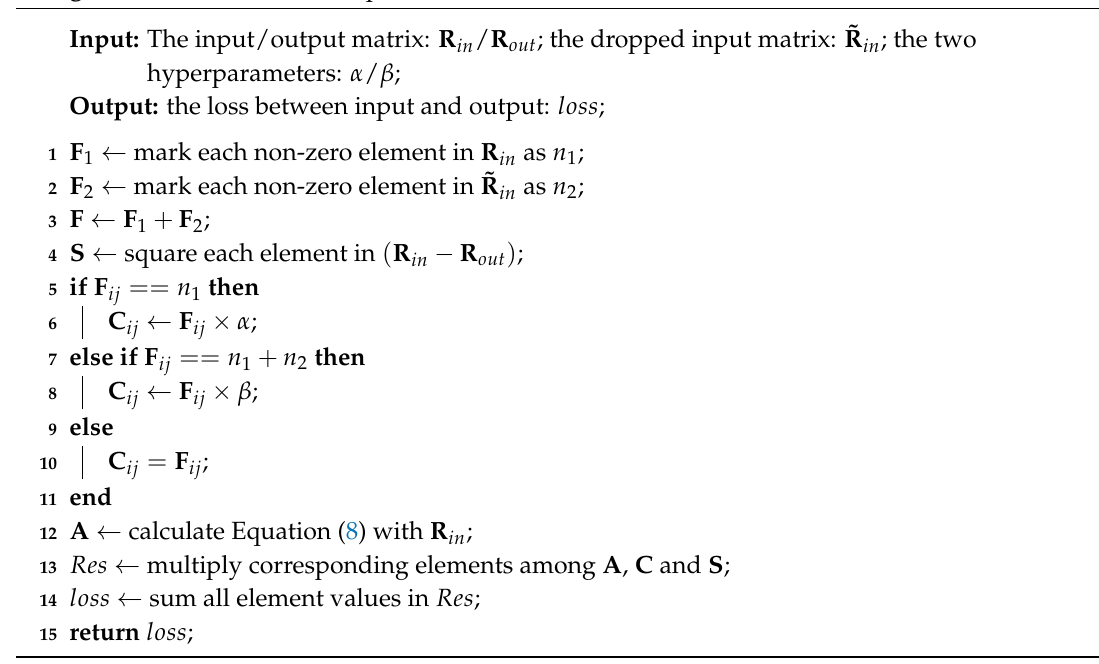
Algorithm 1: The calculation process of the new loss function.